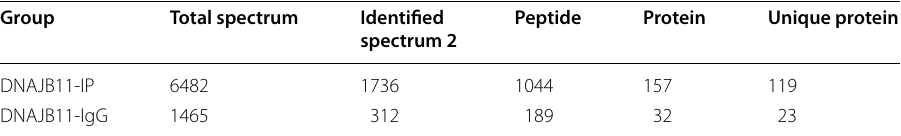
Table 3 Summary of protein identification information in Co-IP-based LC–MS/MS